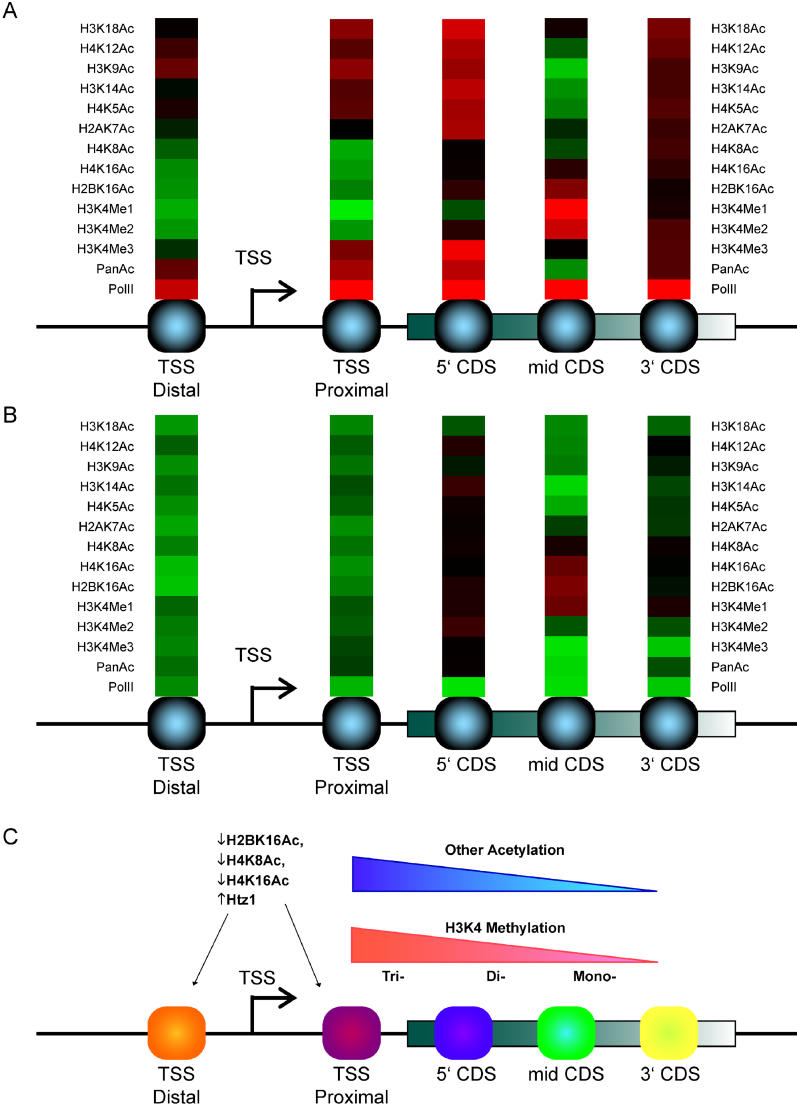
Nucleosome Modifications Partitioned by Location and by Transcription Level(A) Modification patterns of nucleosomes associated with actively transcribed genes. Genes with high levels of PolII occupancy were grouped, and the modification data for the indicated nucleosome types were averaged.(B) Modification patterns of nucleosomes associated with poorly transcribed genes, grouped as in (A), except that genes with low levels of PolII were selected.(C) Schematic view of yeast chromatin architecture. Cartoon view showing chromatin structure of an arbitrary yeast gene. Yeast genes are typically characterized by an upstream nucleosome-free region, which serves as the transcriptional start site [29]. Surrounding this nucleosome-free region are two nucleosomes that exhibit low levels of acetylation at H2BK16, H4K8, and H4K16, and that carry Htz1 in place of the canonical H2A (unpublished data). The remaining acetylations occur in a gradient from 5′ to 3′ over actively transcribed genes. Similarly, actively transcribed genes exhibit a gradient of H3K4 methylation, with trimethylation occurring at the 5′- ends of genes, and di- and mono-methylation occurring over the middle of the coding region. Nucleosomes are coloured to emphasize the different average modification patterns at each indicated location.